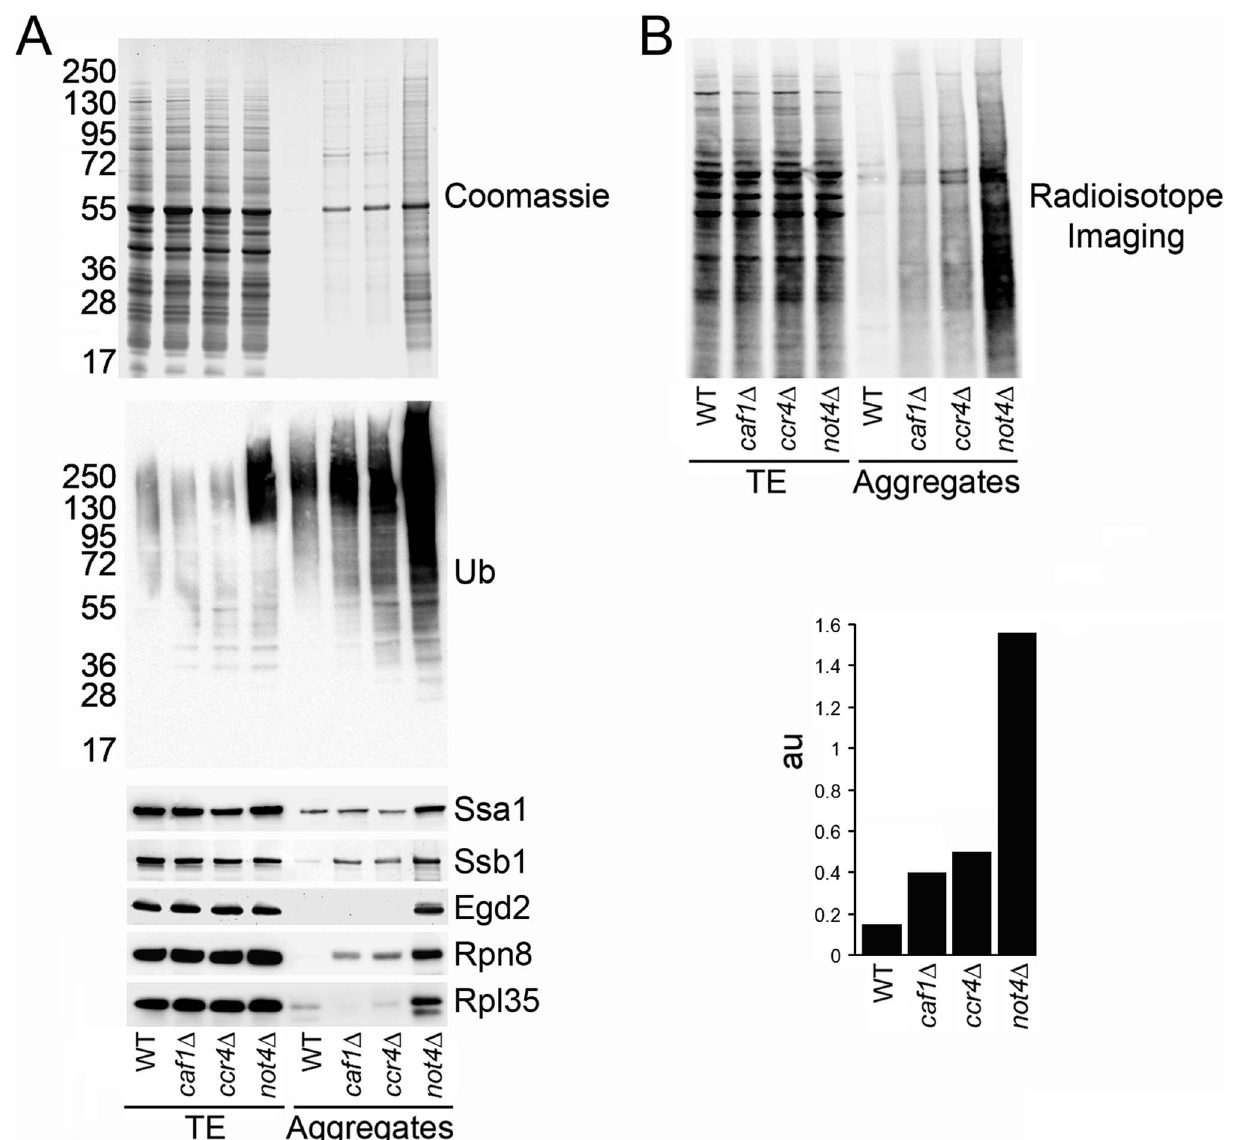
Figure 2. The Not4 deletion caused accumulation of aggregated and polyubiquitinated newly synthesized proteins. A. Aggregates were isolated from the indicated cells and analyzed by SDS-PAGE and Coomassie staining (upper panel), or western blot with antibodies against ubiquitin (middle panel), or against Ssa1, Ssb1, Egd2, Rpn8, and Rpl35 (lower panel). B. Aggregates were isolated from the same cells treated with S 35 -Met for 5 min and analyzed by SDS-PAGE and radioisotope imaging (upper panel). Images were quantified (lower panel). ‘‘au’’ is a ratio of the signal observed in the aggregates to the signal observed in the total protein fraction.